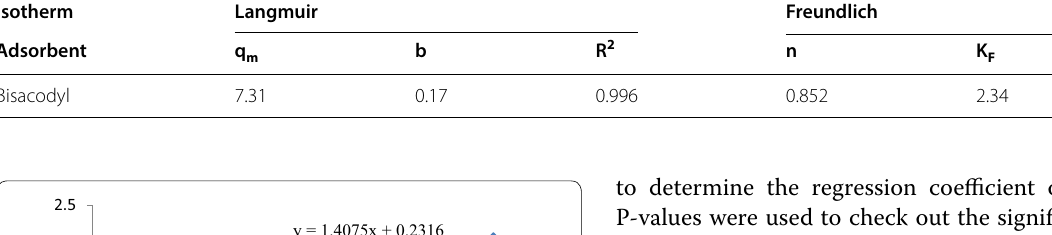
Table 4 Langmuir and Freundlich constants and correlation coefficients for bisacodyl adsorption by mesoporous silica Isotherm Langmuir